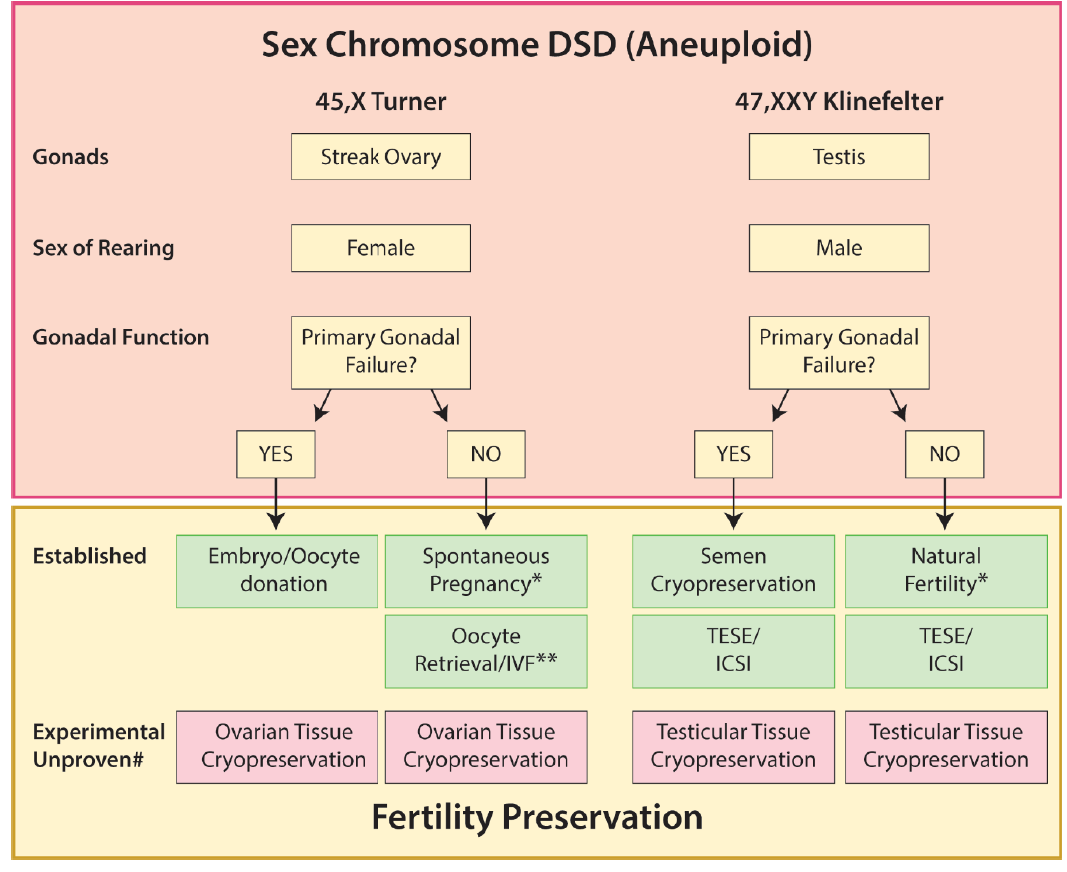
Figure 2. Options for fertility preservation in sex chromosome DSD (aneuploid). * Mostly mosaics. ** Postpubertal. # Potential for gonadal tissue cryopreservation based on published literature